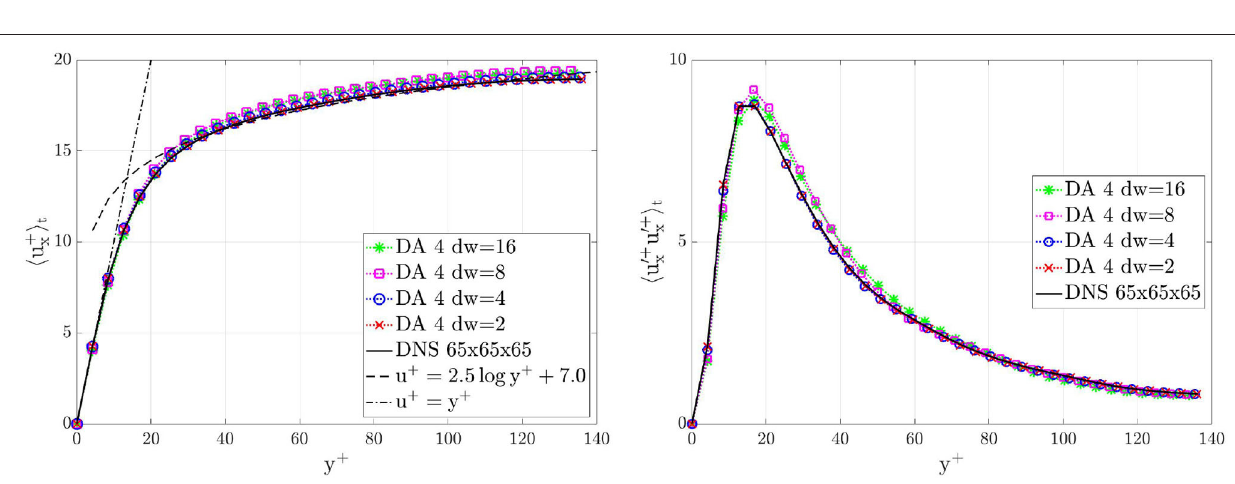
FIGURE 11 | Turbulent channel flow: comparison between DA predictions obtained by using data acquired from window 4 with different downsamplings and ground truth on a line parallel to the y -axis and centered in the z -direction, i.e., z = π h , for x = 3 π h . Left: stream-wise mean velocity profiles h u x ( x = 3 π h , y , z = π h , t ) i t .